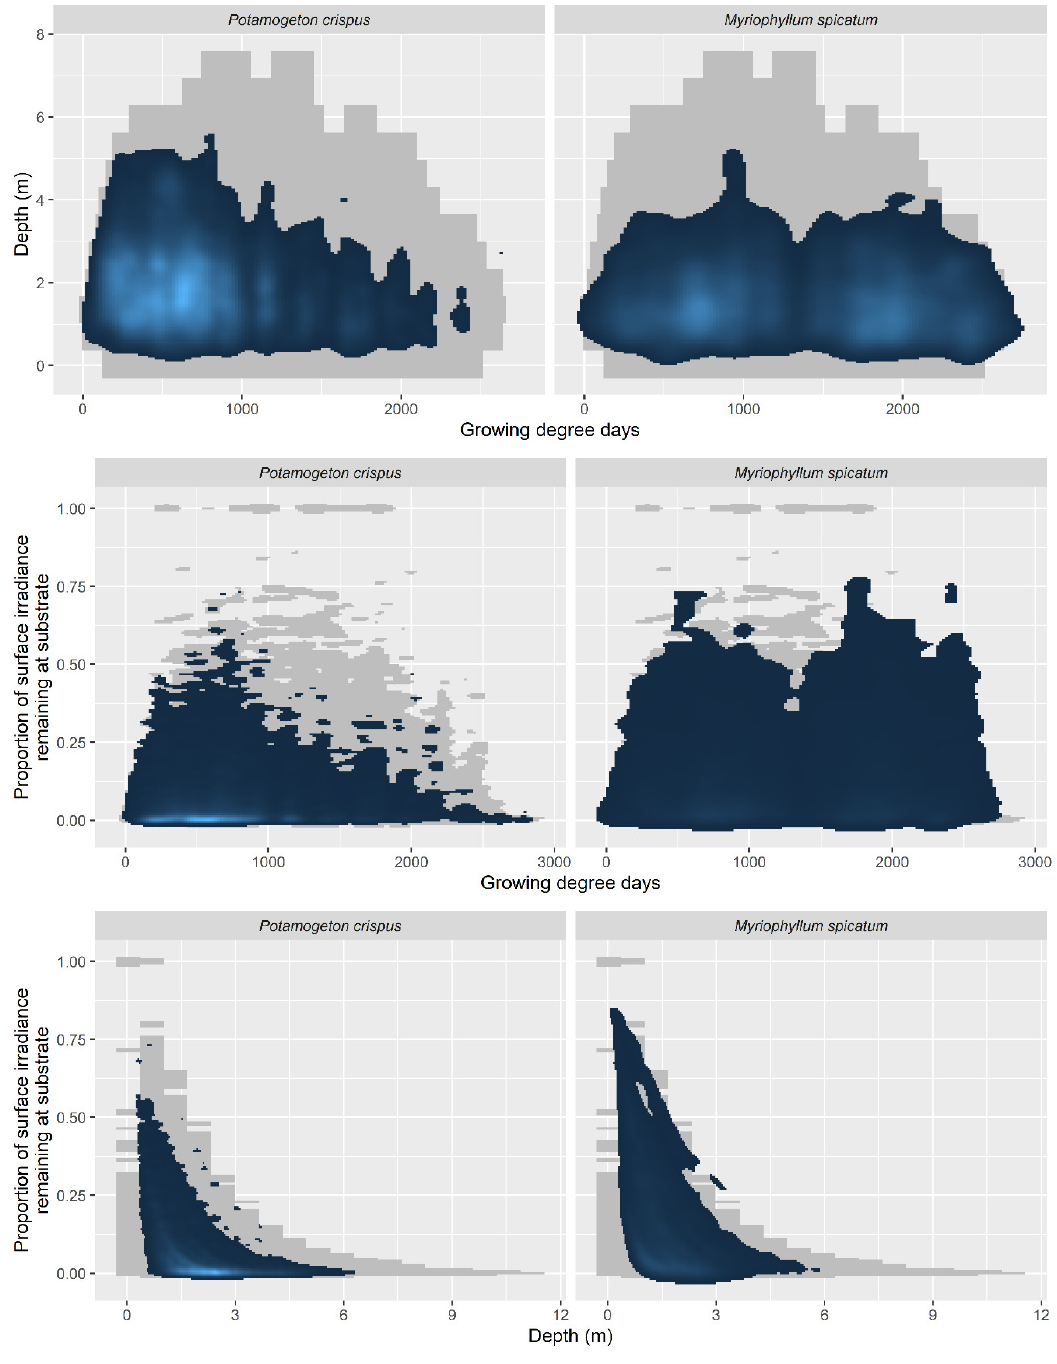
Figure 3. Niche models of Potamogeton crispus and Myriophyllum spicatum across three environmental gradients: water depth, phenology (growing degree days), light availability (proportion of surface irradiance at substrate). Gray background depicts surveyed space in the niches, and blue cloud indicates probabilistic nature of niche model (light blue = high relative abundance; dark blue = low relative abundance).